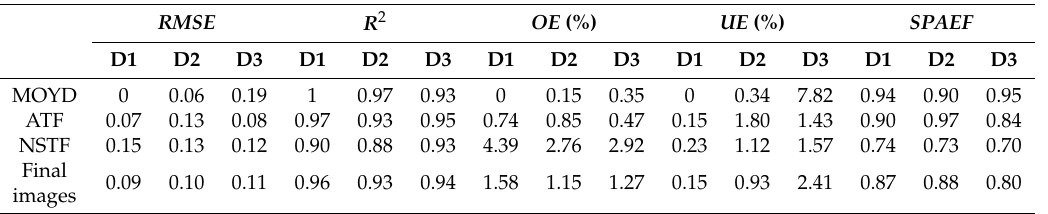
Table 6. Quantitative performance evaluation results for a consecutive three-day cloud mask. RMSE R